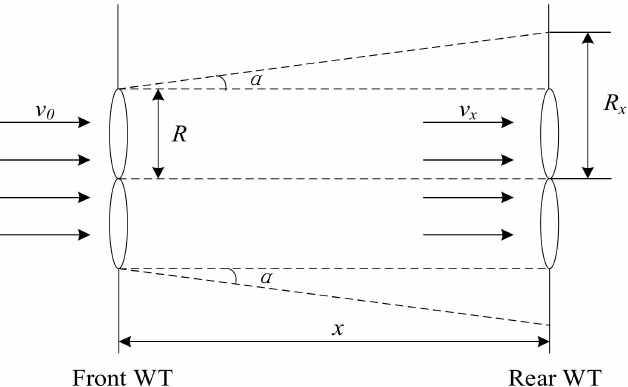
Figure 8. The schematic diagram of the Jensen